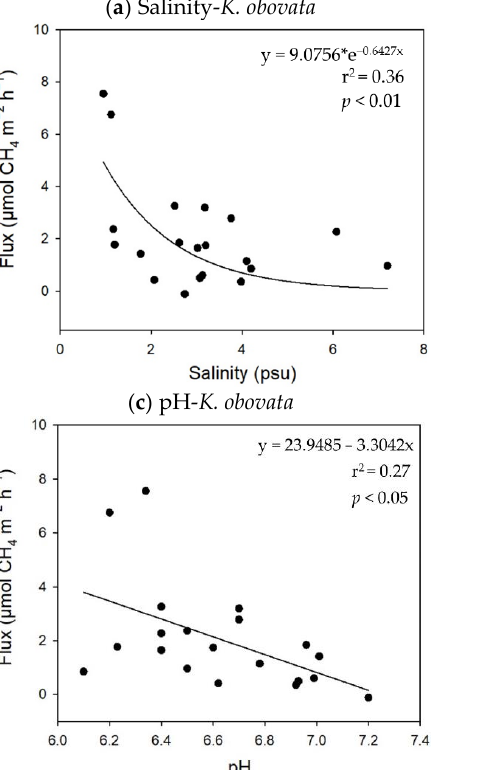
4 flux in the mudflats (n =